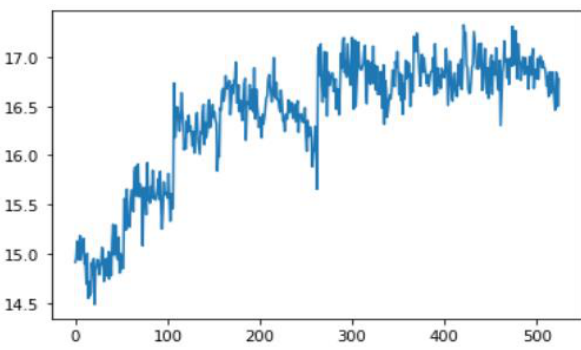
Figure 60. Merged magnetic field data visualization.